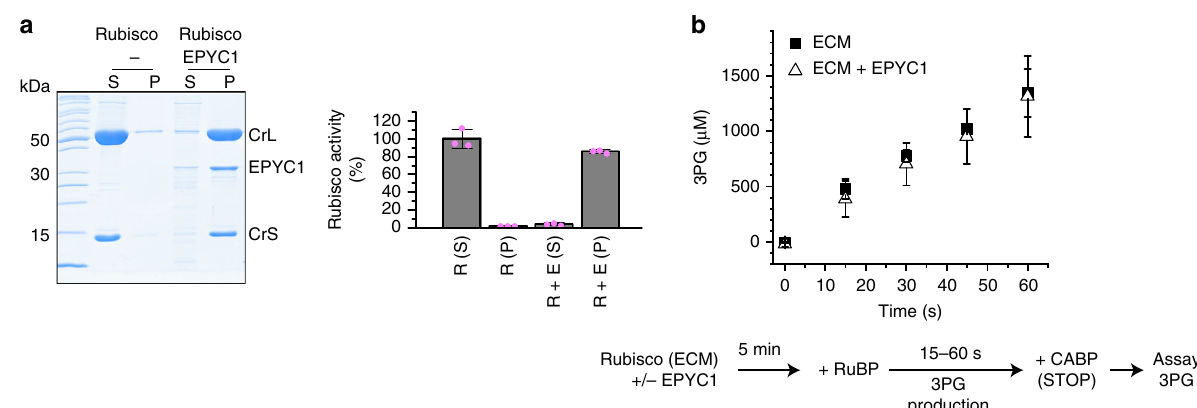
Fig. 2 Demixed Rubisco remains active. a Rubisco remains functional following droplet formation. Pelleted droplets were resuspended in one volume of ECM buffer containing 300 mM NaCl and assayed for Rubisco activity. b Rubisco enzyme activity (indicated as 3PG production) is unaffected by droplet formation. Carboxylation reactions contained 7.5 µ M Rubisco in presence and absence of EPYC1 (3.75 µ M). Error bars indicate s.d. of three